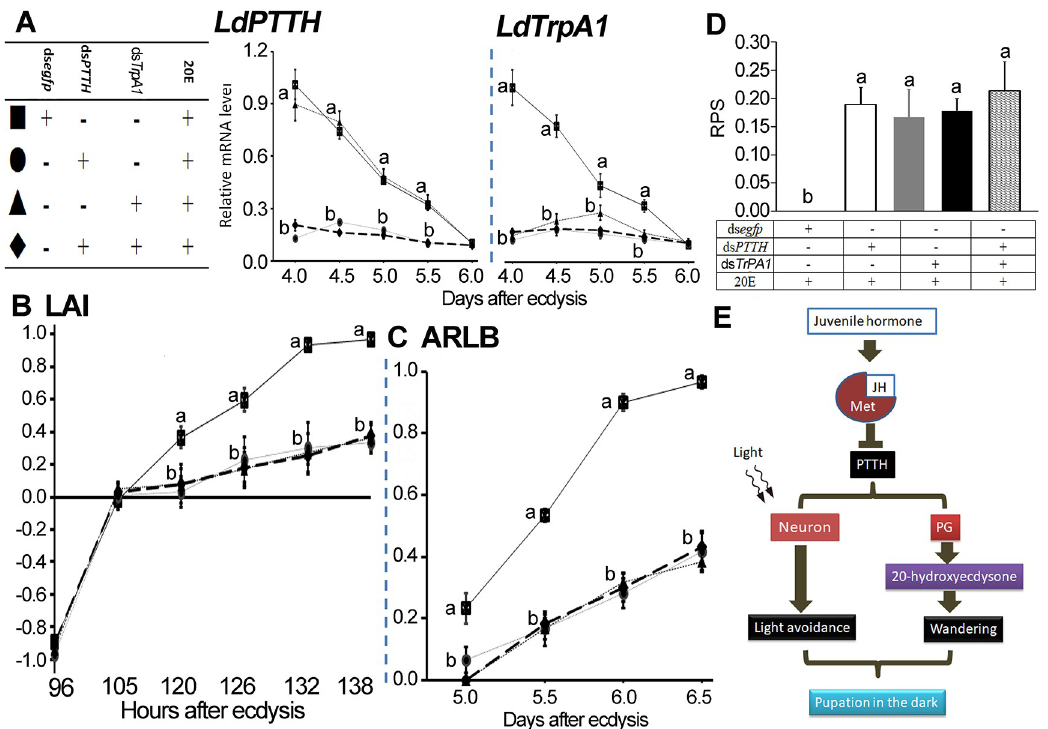
Fig 5. PTTH signal affects photo transduction to promote light sensing. Ds egfp +20E, ds PTTH +20E, ds TrpA1 +20E and ds PTTH +ds TrpA1 +20E were dietarily introduced to the larvae. Significant differences in transcript abundance of LdPTTH and LdTrpA1 (A), light avoidance index (LAI) (B), accumulated rate of larvae that had buried in soil (ARLB) (C) at each testing time point, and rates of pupae on the soil (RPS) (D) through a two-week experiment period to those in control (ds egfp +20E-fed) were indicated by different letters (P < 0.05). (E) A model depicting the hormonal cascade regulating the light avoidance of the wandering larvae (see text for